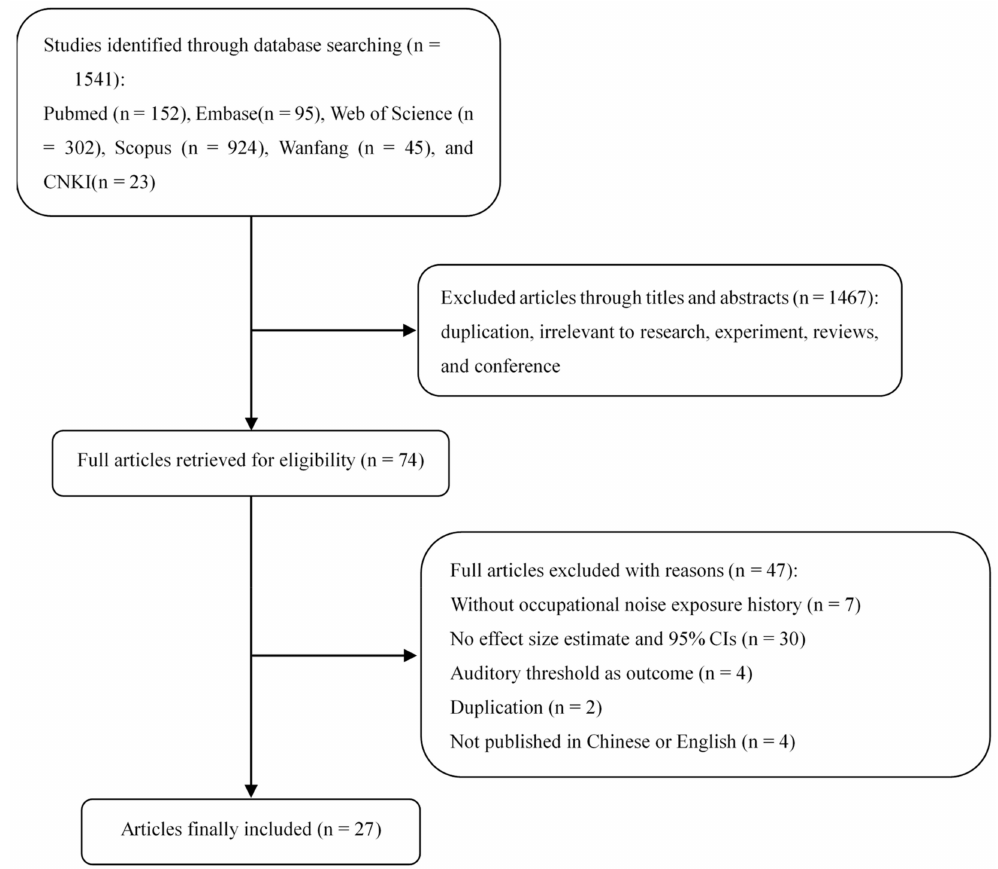
Figure 1. Literature search and selection